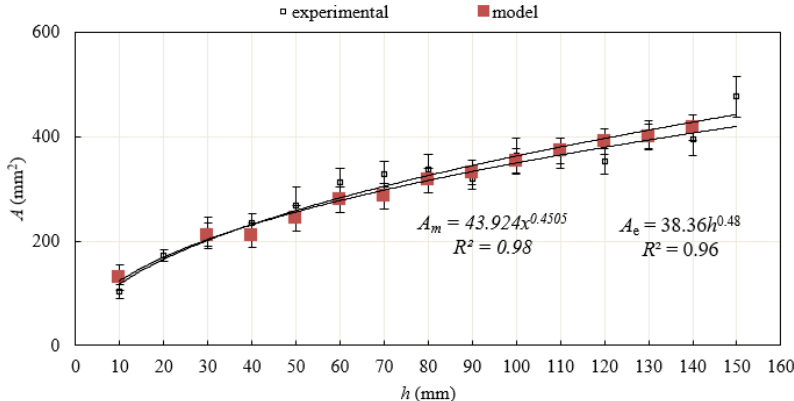
Figure 7. Influence of the drop height on the experimental and model contact surface, for wood type substrates. Am — means model contact surface, Ac — means experimental contact surface. Error bars represent mean ± SD (standard deviation).